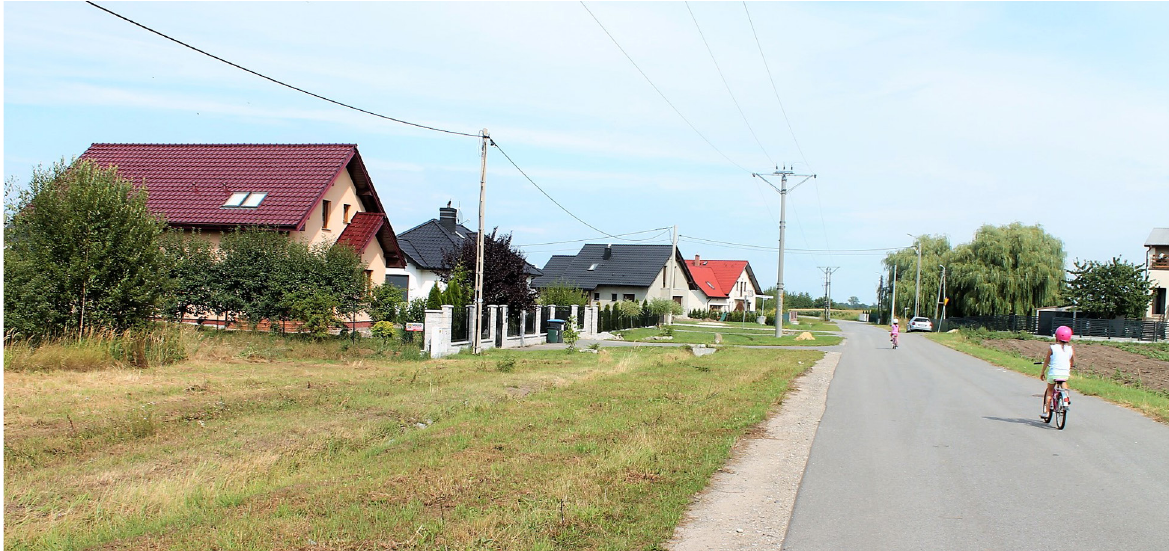
Fig. 5. A new model of the settlement space of Borek Strzeliński in its northern area – a villa type characteristic of a suburban area. Source: J.